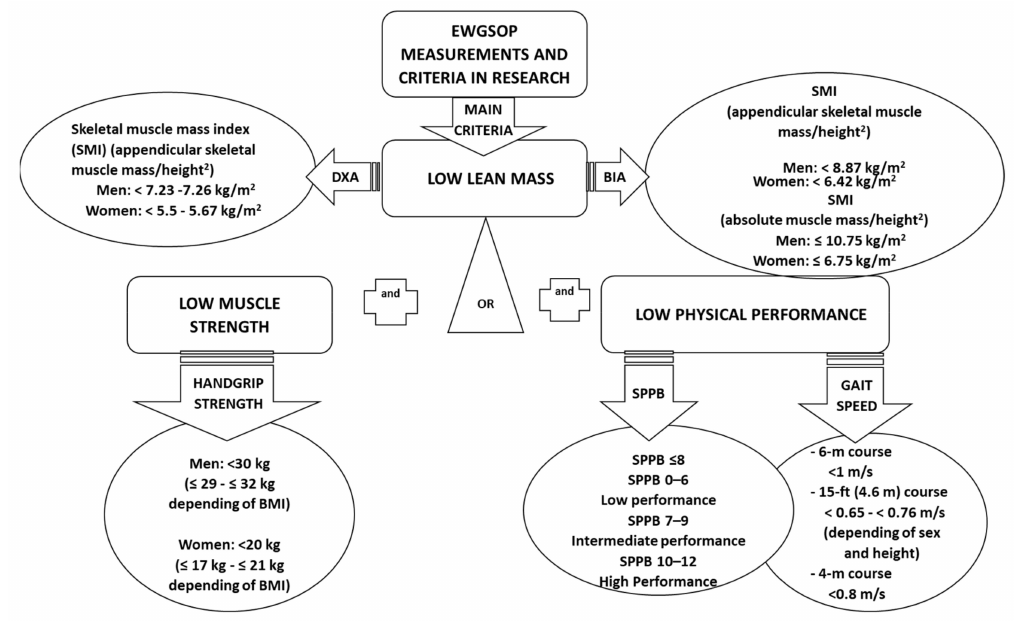
Figure 2. Sarcopenia criteria based on European Working Group on Sarcopenia in Older People (EWGSOP)